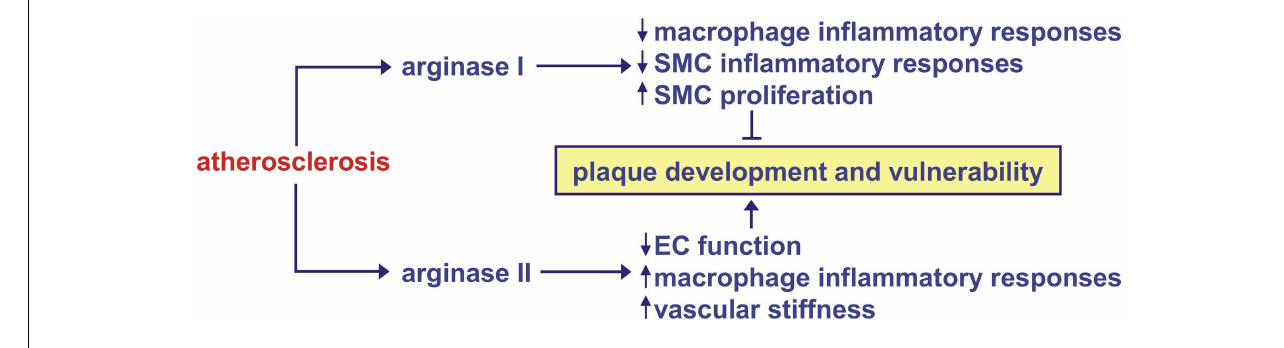
macrophages, and arterial stiffness. In contrast, the induction of arginase I expression in atherosclerosis promotes plaque stability by blocking the inflammatory responses of macrophages and vascular smooth muscle cells (SMCs) and stimulating the proliferation of vascular